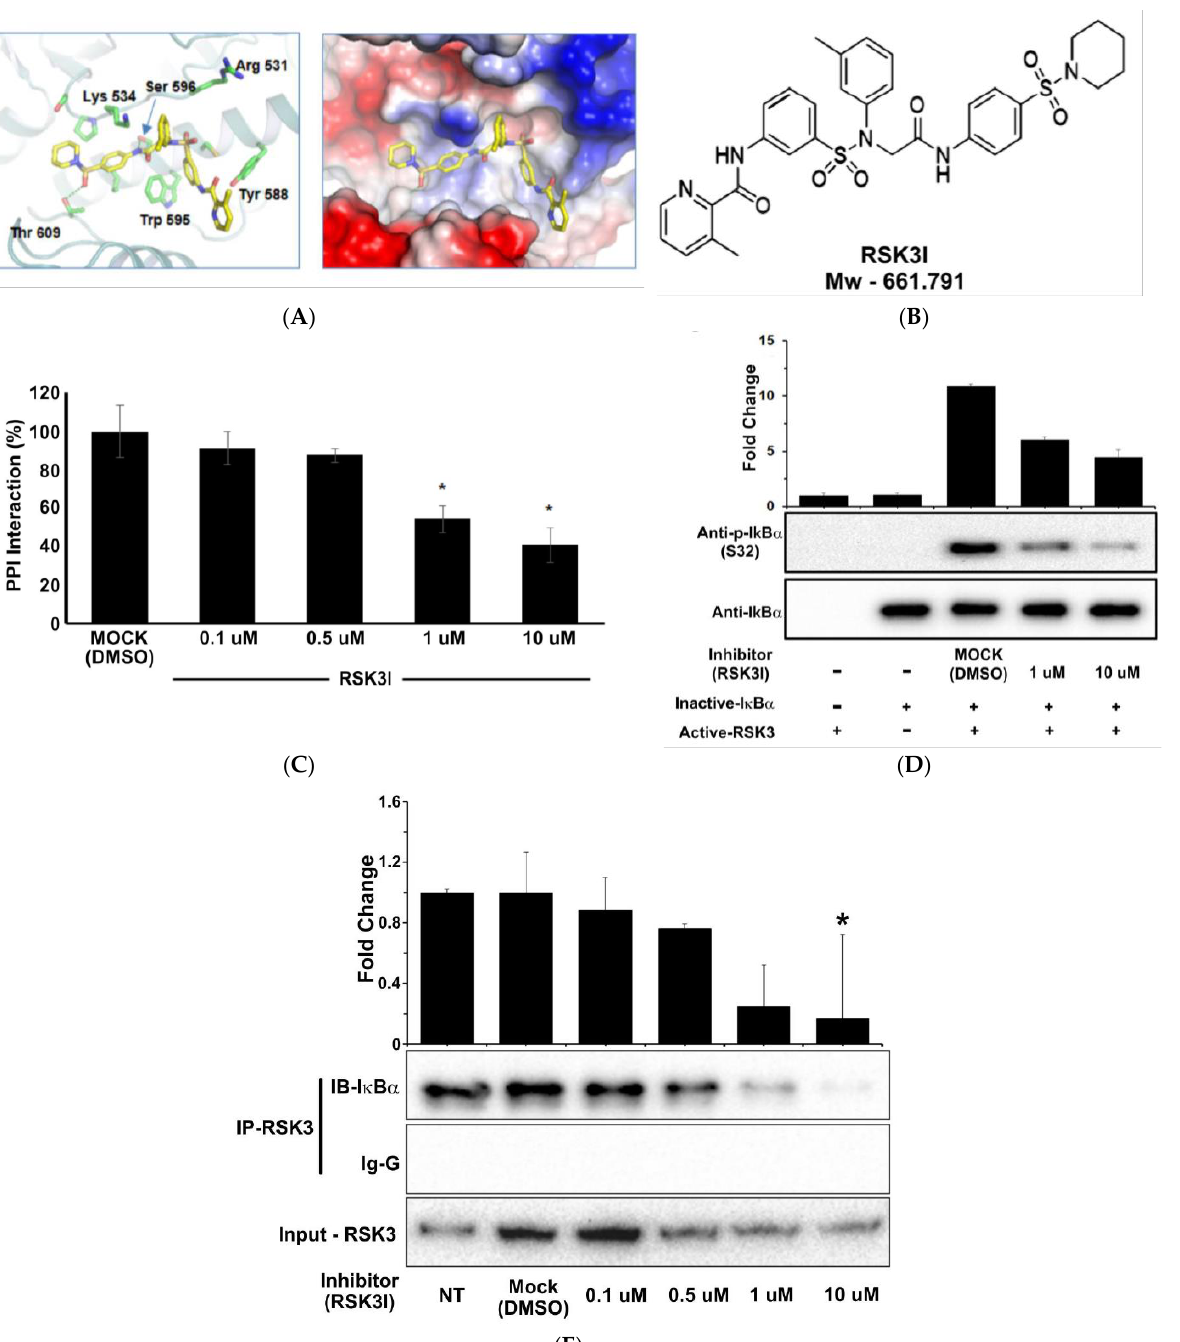
Figure 4. RSK3I inhibits the binding of RSK3 to I κ B α . ( A ) A three-dimensional model of the RSK3 structure and the RSK3/I κ B α binding inhibitor RSK3I. ( B ) Chemical structure of RSK3I. The molecular weight is 661.791 Da. ( C ) MTH assays were performed by transfecting pACT-RSK3 and pBIND-I κ B α into HEK293T cells. RSK3I was added 4 h after transfection in a dose-dependent manner. Luciferase activity was measured 24 h after transfection (* p < 0.05 relative to mock). ( D ) RSK3 in vitro kinase assays were performed with dose-dependent treatment of RSK3I (1 µ M and 10 µ M). I κ B α phosphorylation was detected using Western blot analysis. Representative results from two experiments are shown. ( E ) Immunoprecipitation used RSK3 or control Ig-G antibodies in HEK293T cells transfected with Myc/His-I κ B α and pAC-GFP-RSK3. RSK3I was added in a dose-dependent manner (0.1 µ M, 0.5 µ M, 1 µ M, and 10 µ M). DMSO was used as a vehicle control (MOCK). Co-immunoprecipitated I κ B α was identified by Western blotting with an I κ B α antibody (* p < 0.05). Representative results from three experiments are